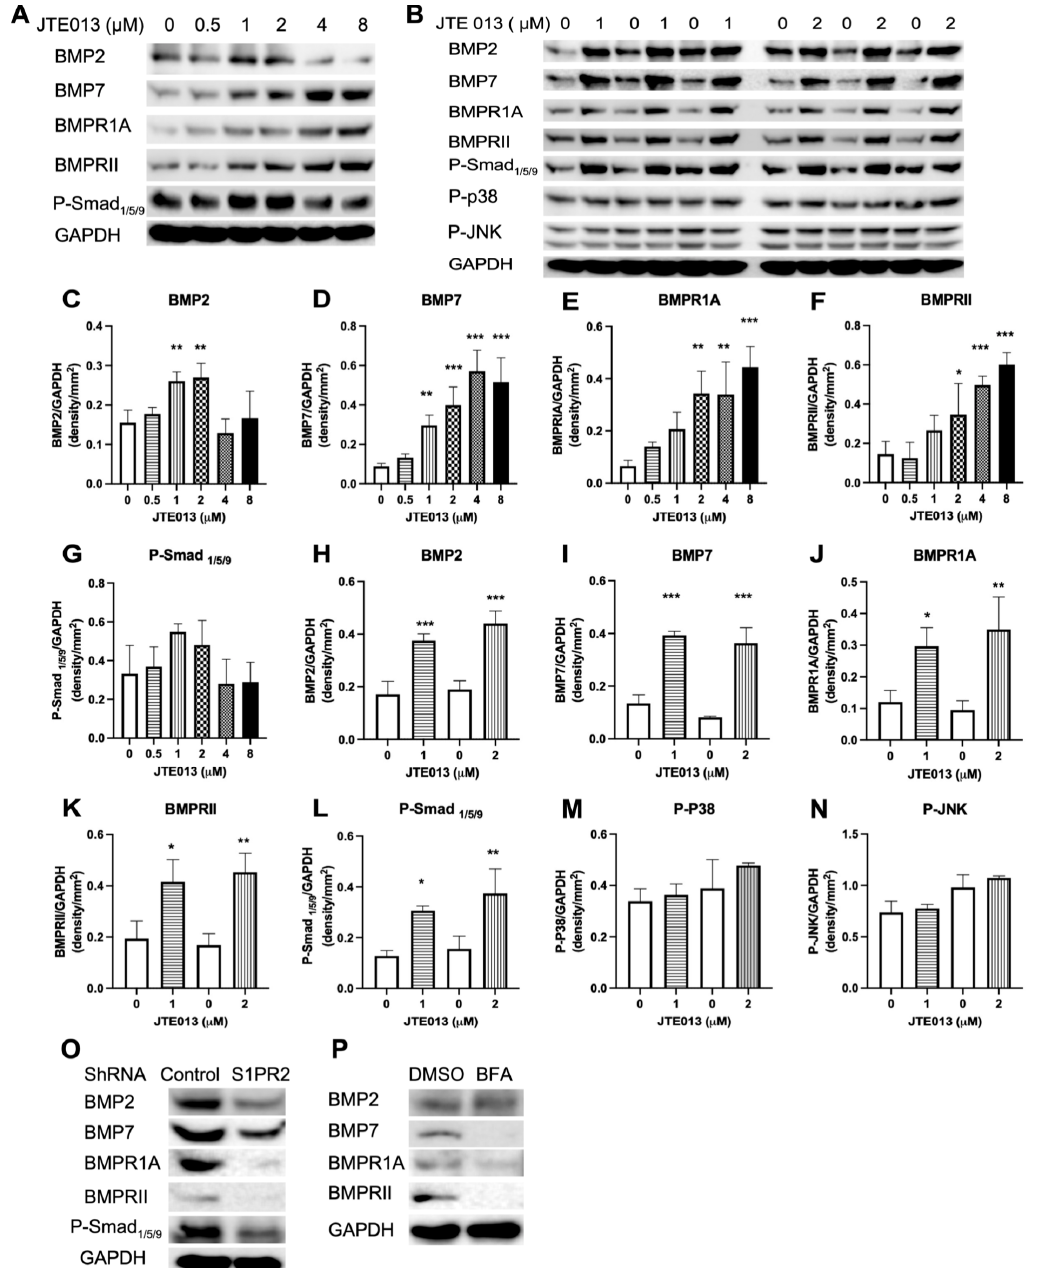
Figure 7. Low doses (1 to 2 μ M) of JTE013, but not a S1PR2 shRNA, increased BMPs/Smad signaling in murine BMSCs cultured in osteogenic media. Murine BMSCs were cultured in osteogenic media with either DMSO or JTE013 for 9 days. Proteins were harvested 30 min after changing osteogenic media with or without JTE013. ( A ) BMP2, BMP7, BMPR1A, BMPRII, p-Smad 1/5/9 , and GAPDH protein levels in BMSCs treated with DMSO or JTE013 (0.5 to 8 μ M). ( B ) BMP2, BMP7, BMPR1A, BMPRII, p-Smad 1/5/9 , p-p38, p-JNK, and GAPDH protein levels in BMSCs treated with DMSO or JTE013 (1 or 2 μ M). Protein densitometry of ( C , H ) BMP2, ( D , I ) BMP7, ( E , J ) BMPR1A, ( F , K ) BMPRII, ( G , L ) p-Smad 1/5/9 , ( M ) p-p38, and ( N ) p-JNK was normalized by GAPDH protein expression in BMSCs (n = 3, * p < 0.05, ** p < 0.01, *** p < 0.001). ( O ) BMP2, BMP7, BMPR1A, BMPRII, p-Smad 1/5/9 , and GAPDH protein levels in BMSCs treated with a control shRNA or a S1PR2 shRNA and cultured in osteogenic media for 9 days. ( P ) BMP2, BMP7, BMPR1A, BMPRII, and GAPDH protein levels in BMSCs treated with DMSO or brefeldin A (BFA, 0.75 μ M) and cultured in osteogenic media for 6 days. In murine BMSCs treated with the S1PR2 shRNA, the protein levels of BMP2, BMP7, BMPR1A, BMPRII, and p-Smad 1/5/9 were attenuated compared with those protein